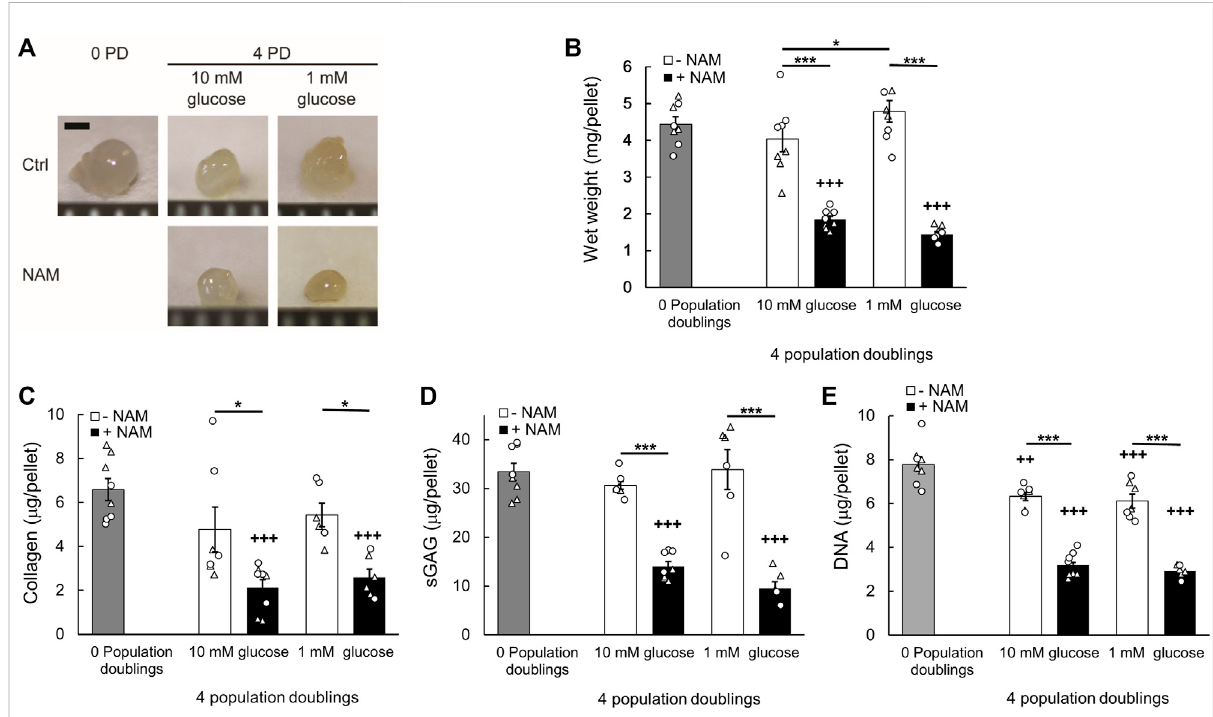
FIGURE 4 Inhibition of sirtuin activity during monolayer expansion abrogates chondrocyte regenerative capacity. (A) Representative cell pellets at day 28 of 3D culture created from chondrocytes which were either freshly isolated, 0 population doublings (0 PD), or monolayer expanded for 4 PDs in mediacontainingeither10 mMor1 mMglucoseinthepresenceorabsenceofthesirtuininhibitornicotinamide(NAM).Scalebar1 mm. (B) Pelletwet weight, (C) collagen content, (D) sulphated glycosaminoglycan (sGAG) content, and (E) DNA content at day 28. Mean ± s.e.m, n 0PD = 8 (B – E)